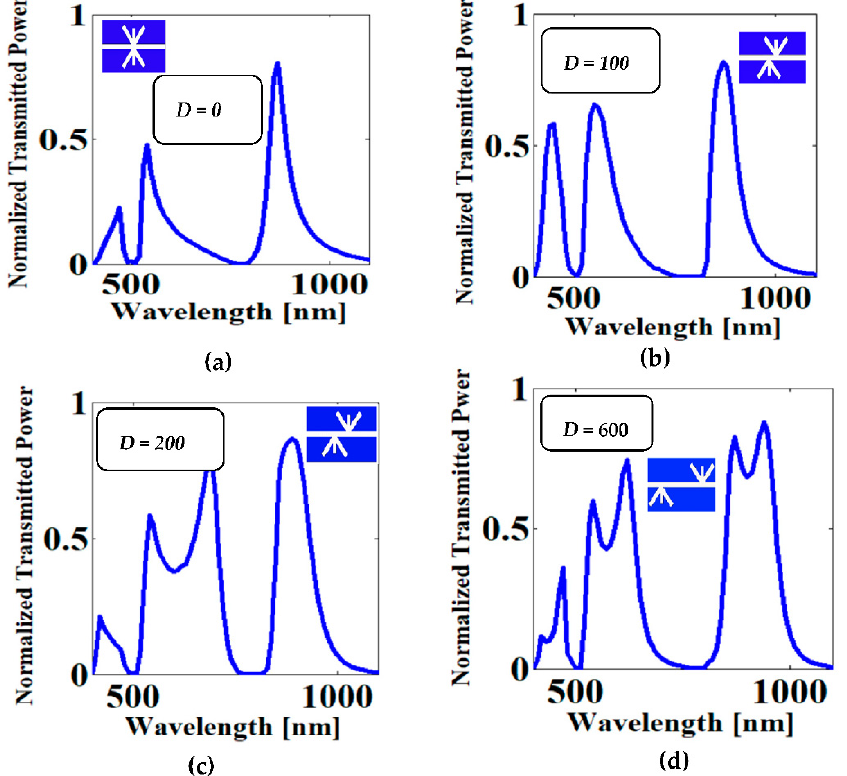
Figure 3. Transmission spectra with different coupling distance between two plasmonic arrows: ( a ) D = 0 nm, ( b ) D = 100 nm, ( c ) D = 200 nm, and ( d ) D = 600 nm. Table 3. Filter characteristics with various coupling distances between two arrow resonators (values extracted from Figure 3).